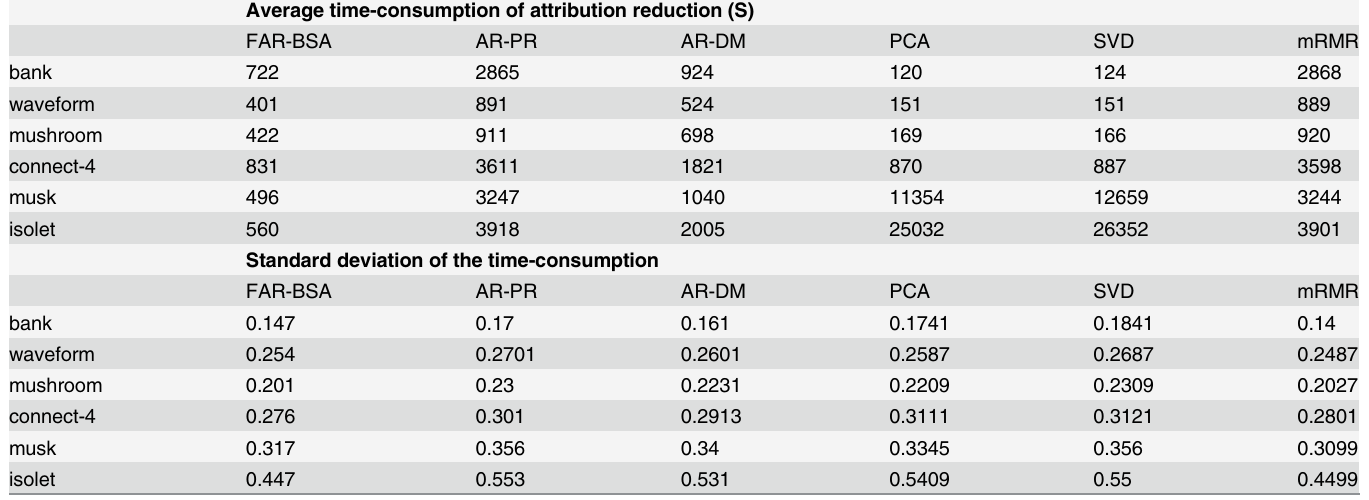
time-consumption of the function mining based on centralized GEP for the bank, waveform, mushroom, connect-4, musk and isolet datasets is relatively stable and close to the average value for the time-consumption under the condition that these algorithms were run 10 times. Table 3. Comparison of the average time-consumption and standard deviation of the time-consumption between FAR-BSA and other reduction